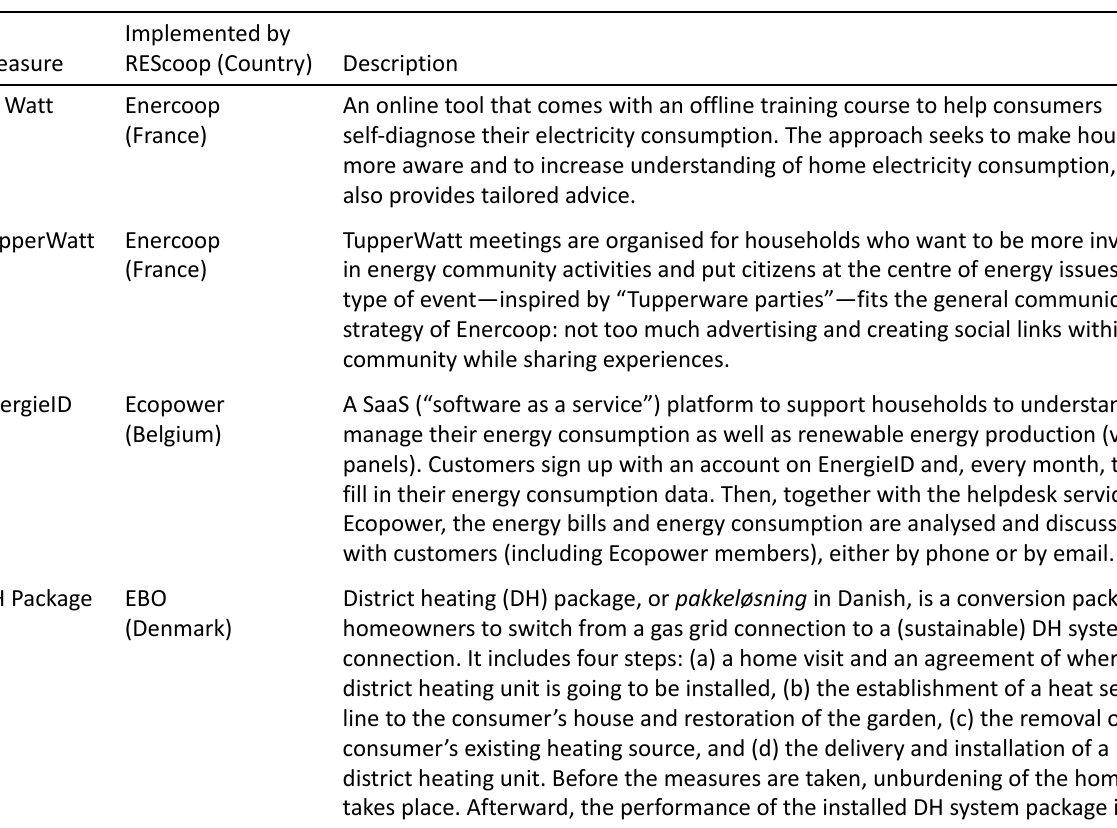
Table 1. Overview of illustrative specific dedicated measures used by energy